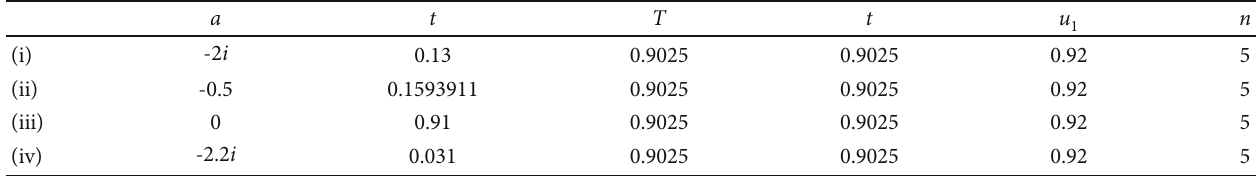
Figure 11: E ff ect of change in parameters a and t simultaneously on quintic Mandelbrot set. Table 10: Parameters for generation of quintic Mandelbrot set for di ff erent values of a and t